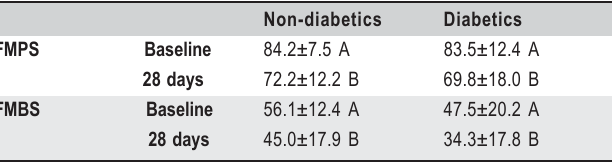
Table 2. Full mouth Plaque (FMPS) and bleeding scores (FMBS) in diabetic and non-diabetic subjects before and after supragingival